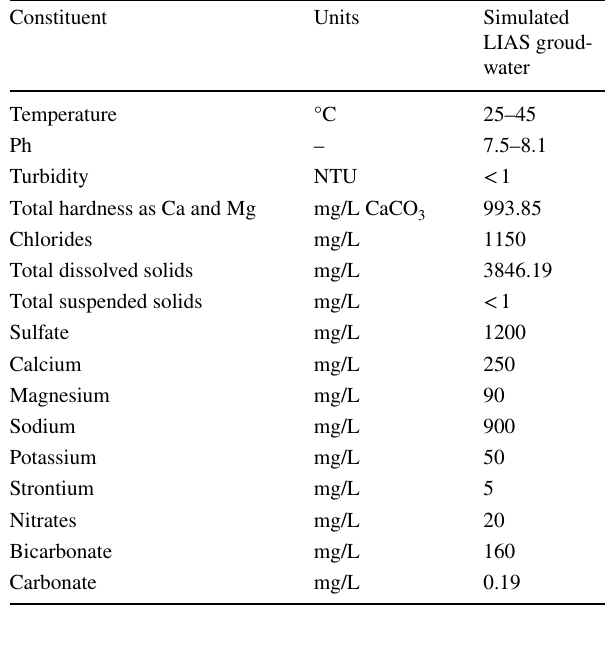
Table 2 Physico-chemical brackish LIAS groundwater quality